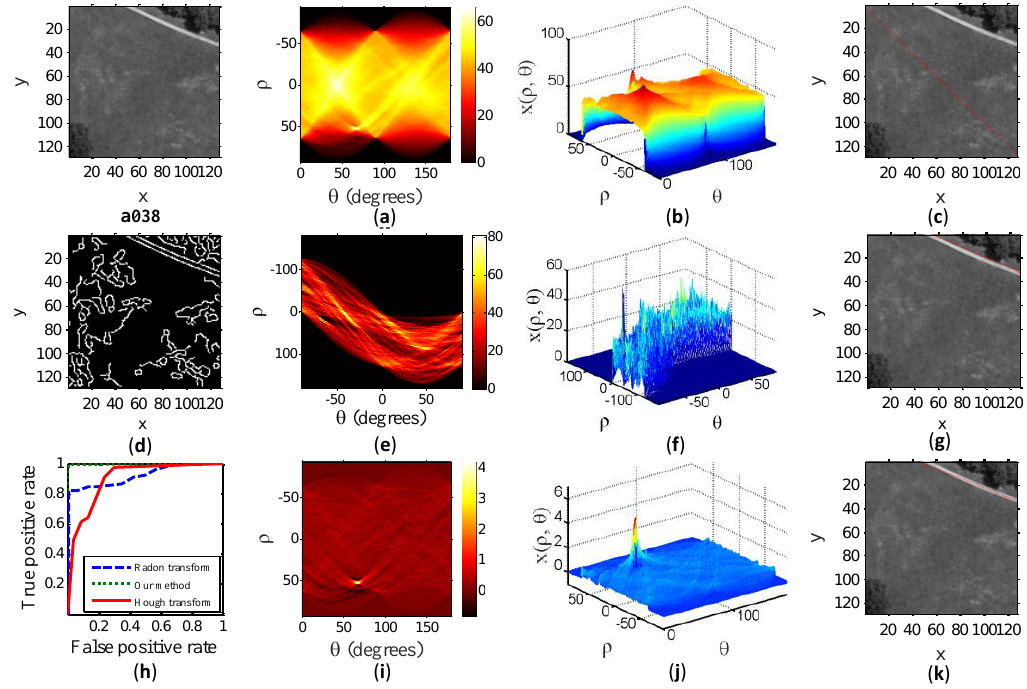
Figure 8. a038 is a test image. ( a ) Radon transform of test image in two-dimensional parameter space. ( b ) Three-dimensional form of ( a ). ( c ) Detected line from ( b ) overlaid on test image. ( d ) Binary image of the test image. ( e ) Hough transform of ( d ). ( f ) Three-dimensional form of ( e ). ( g ) Detected line from ( f ). ( h ) Receiver Operator Curves of the evaluated detection methods. ( i ) Transform image obtained by our method. ( j ) Three-dimensional form of ( i ). ( k ) Detected line from ( j ). Table 3. The mean-error and variance of two methods.